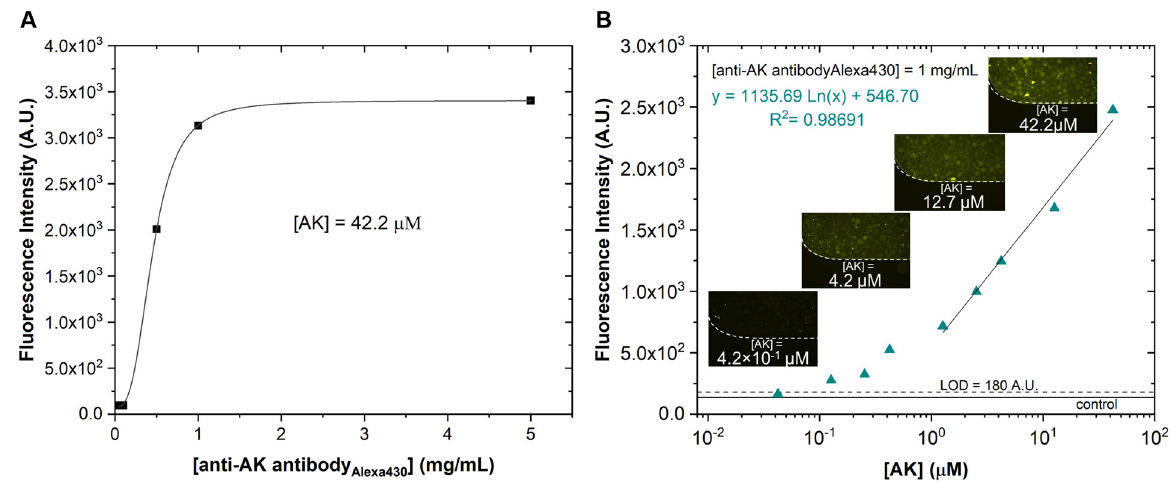
Figure 5. Immunoassay for AK detection: ( A ) optimisation of the labelled anti-AK antibody concen- tration for a fixed AK concentration (42.2 µ M). Capture and wash steps were performed at 1 µ L/min and 5 µ L/min, respectively; ( B ) fluorescence response curve for different target synthetic AK con- centrations, ranging from 1 × 10 − 1 to 42.2 µM, using the optimised assay conditions, and linear re- gression (y = 1135.69 Ln(x) + 546.70). The control corresponds to the assay without target AK, estab- lishing the baseline for non-speci fi c interactions and residual capture of detection antibodies (n = 3). The excitation wavelength was 450–490 nm (blue).